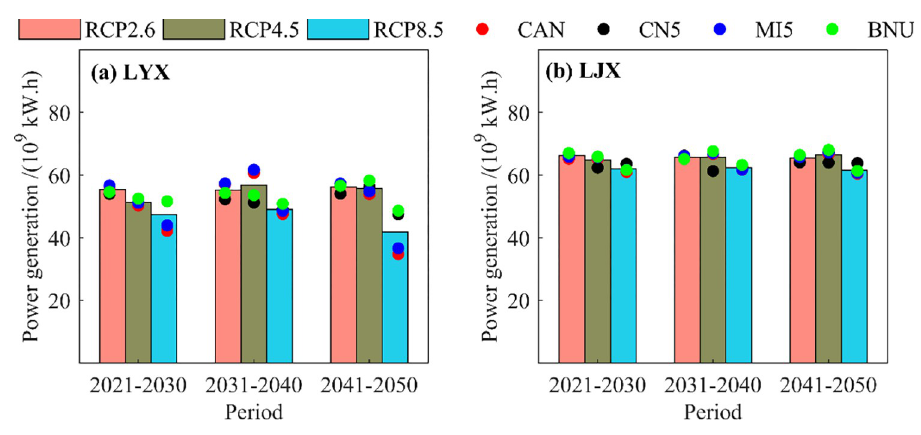
Fig 9. Total power production of LYX and LJX reservoirs under different climate models. figure: (1) under different climate scenarios (RCPs), there are certain differences in the multi- year average power generation of Liujiaxia reservoir is greater than the Longyangxia reservoir.